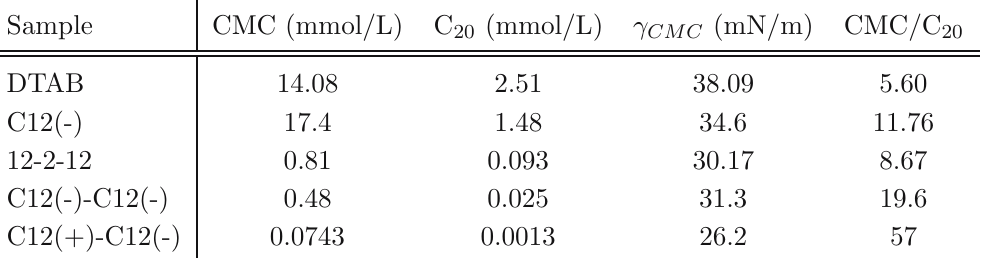
Table 3 The data of CMC, γ CMC and C 20 obtained from Fig.